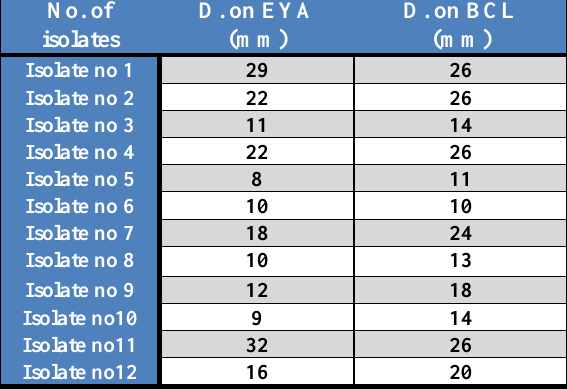
Table, 4: Production of phosphlipase C (Diameter) from Pseudomonas aeruginosa isolates in sheep . No. of